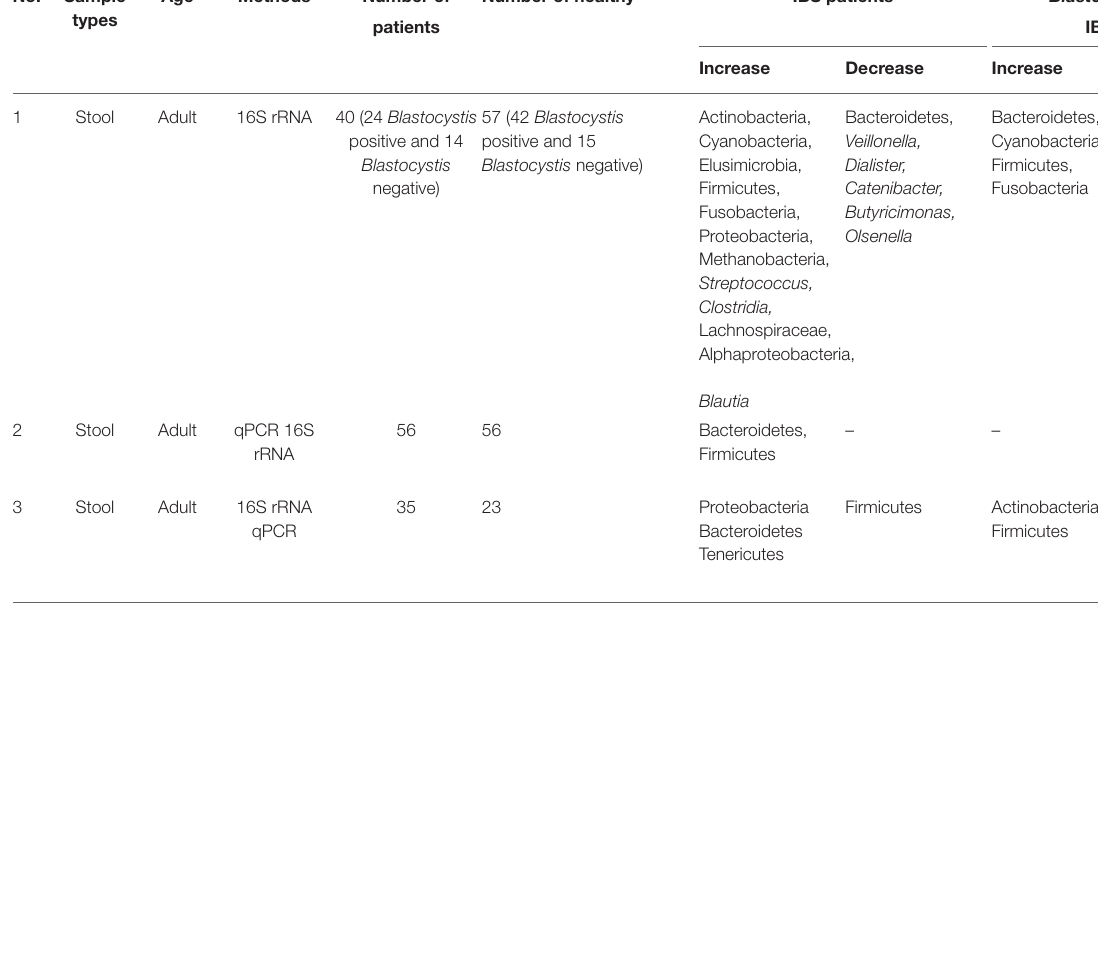
TABLE 2 | The gut microbiota changes in patients with IBS carrying Blastocystis sp. No. Sample